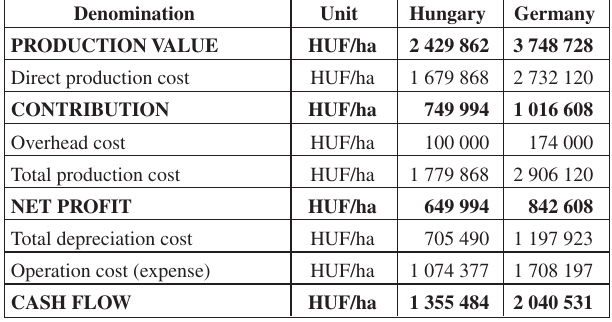
Table 4. Results of Farming in the Productive Period*